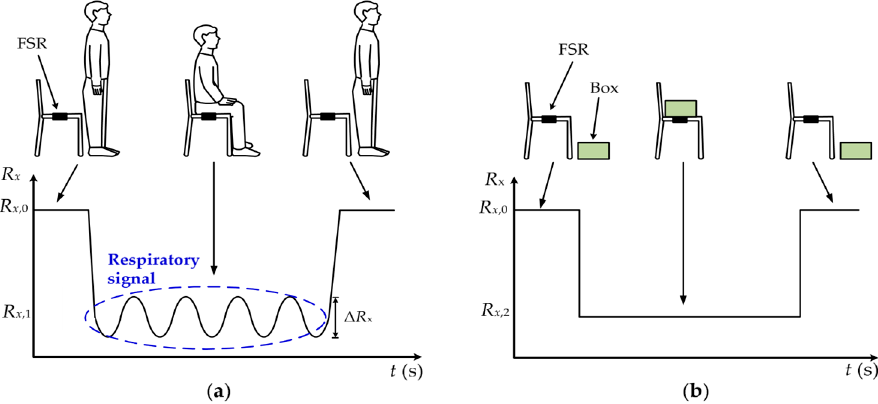
Figure 1. FSR variations when over the chair we have: ( a ) a subject; ( b ) an object.